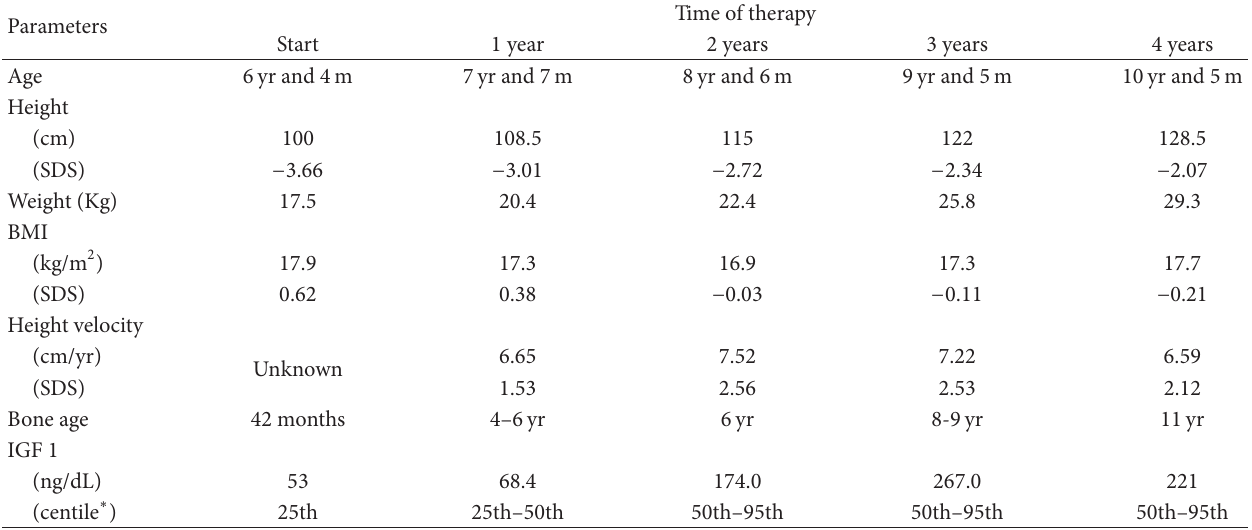
T 1: Clinical, hormonal, and radiological parameters of the patient during GH